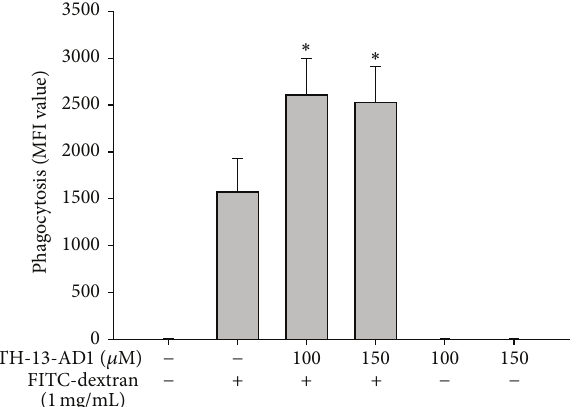
Figure 4: Effect of KTH-13-AD1 on the phagocytic uptake of RAW264.7 cells. RAW264.7 cells preincubated with KTH-13-AD1 were treated with FITC-dextran (1mg/mL) for 20 min. The level of dextran uptake was determined through flow cytometric analysis. ∗ 𝑃 < 0.05 compared to the vehicle control.